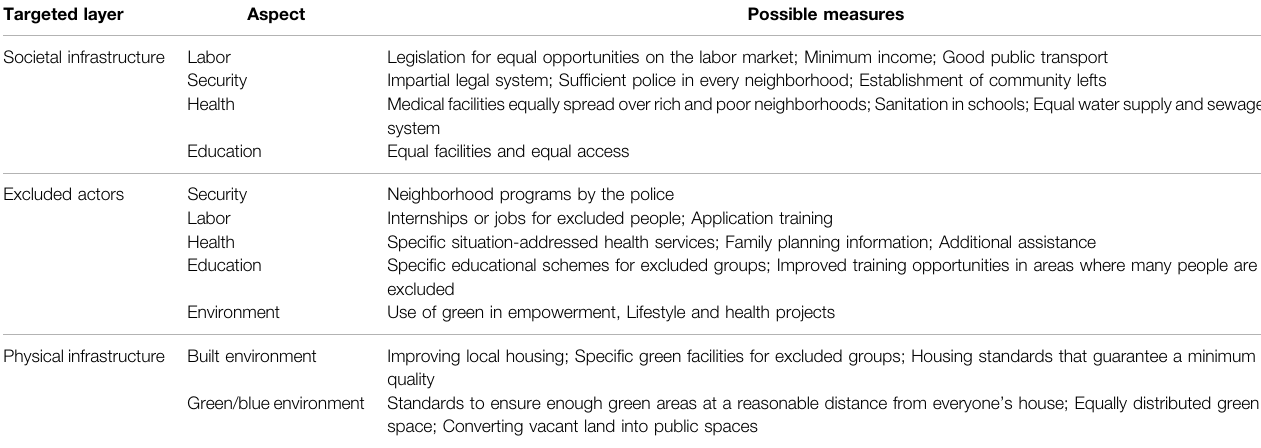
TABLE 1 | Possible measures to combat exclusion classi fi ed in layers of the proposed model.